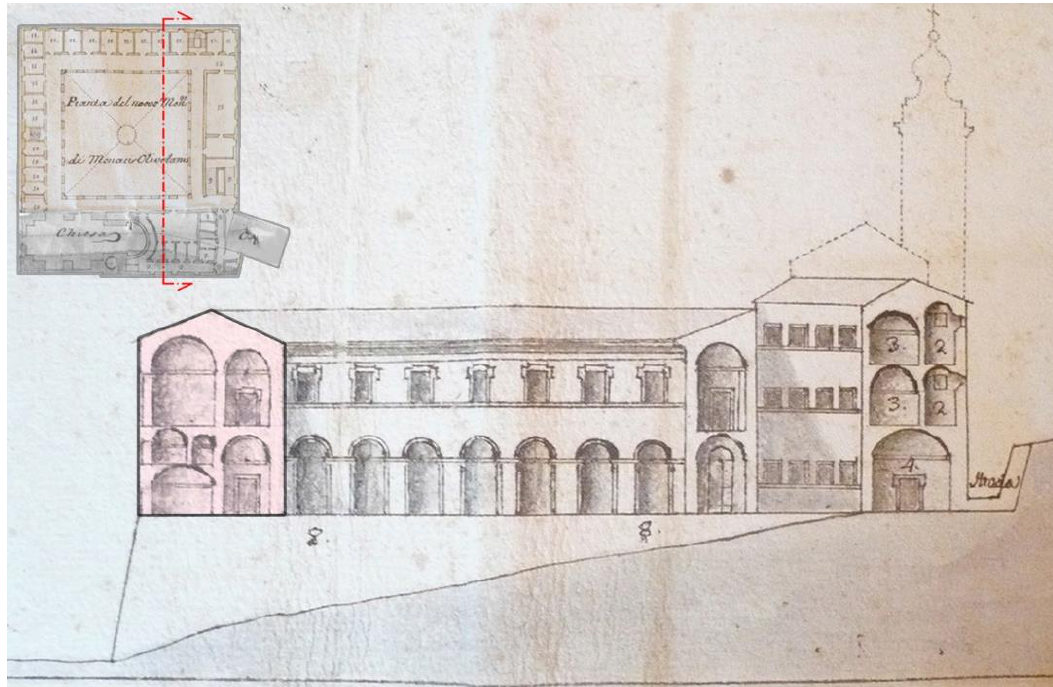
Figure 7. Re-elaboration of the original design drawings of the monastery of Monte Morcino Nuovo from Luigi Vanvitelli and the wall of the camp of the St. Benedict’s nuns. On the right, in light red, the cross-section of Vanvitelli’s Modulus. Extracted from the researches of C. Sorignani (State Archives of Perugia, 1739) [8].